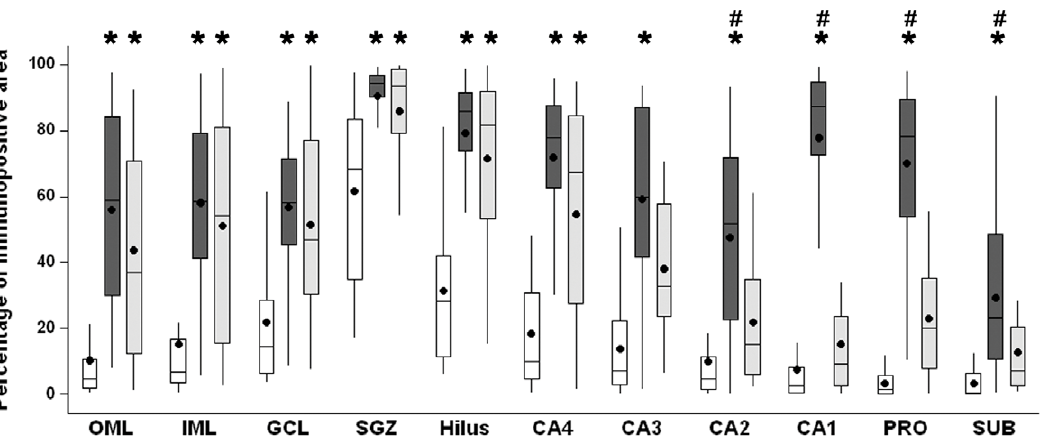
Figure 5. GFAP immunopositive area in hippocampal subfields of Ctrl, MTLE and TLE-TD groups. Compared to Ctrl (white boxplots), MTLE (dark gray boxplots) and TLE-TD (light gray boxplots) groups had increased GFAP immunoreactivity (showed as percentage of immunopositive area) in outer molecular layer (OML), inner molecular layer (IML), granule cell layer (GCL), subgranule zone (SGZ), hilus, CA4 and CA3 (p , 0.001), and MTLE groups had increased GFAP immunopositivity in CA2, CA1, prosubiculum (PRO) and subiculum (SUB), compared to Ctrl and TLE-TD (p , 0.001). In the subiculum (SUB), TLE-TD had increased GFAP immunoreactivity, compared to Ctrl (p , 0.001). The * indicate difference from Ctrl and # difference from TLE-TD.